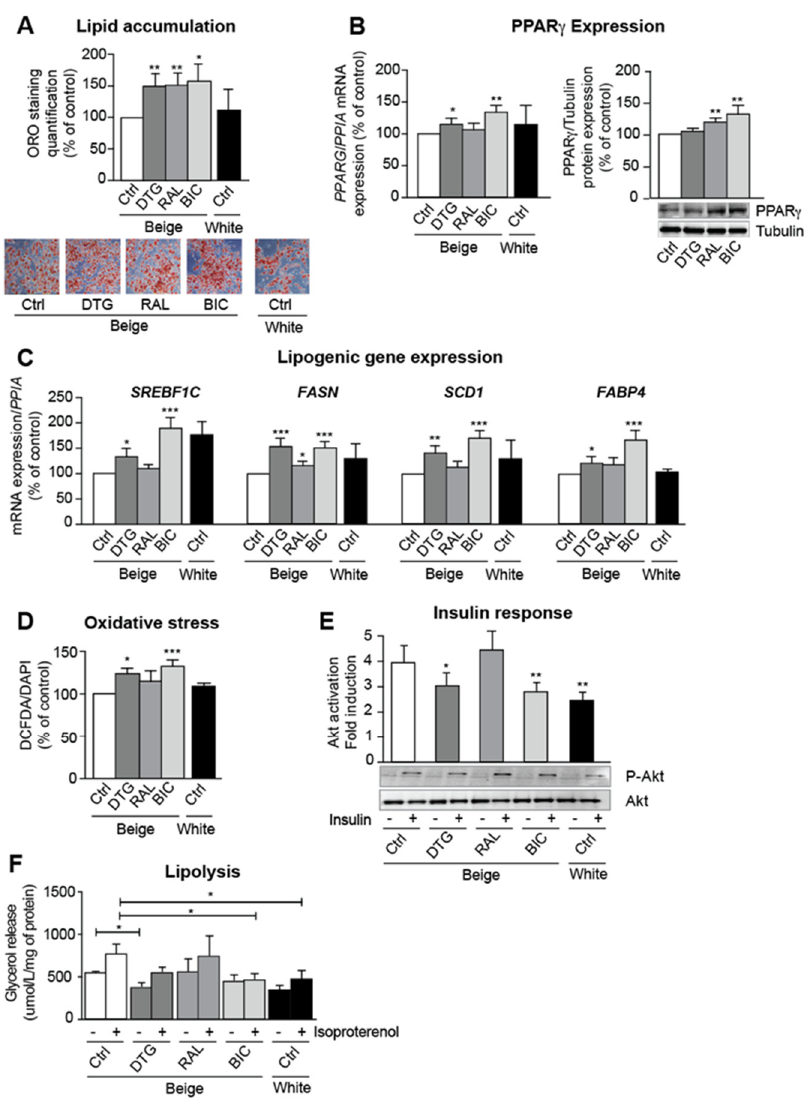
Figure 2. INSTI treatment is associated with greater lipid accumulation, pro-lipogenic marker expression, and insulin resistance in beige adipocytes in vitro. ASCs were differentiated into beige adipocytes in the presence of DMSO (Ctrl), dolutegravir/DTG, raltegravir/RAL, or bictegravir/BIC or differentiated into white adipocytes with DMSO (Ctrl) for 14 days. ( A ) Representative pictures are shown (Magnification X10). Oil-Red-O staining was expressed as the mean ± SEM % of control cells ( n = 9, in triplicate). ( B ) The relative mRNA expression levels of PPARG were normalized against that of PPIA . The results are expressed as the mean ± SEM % of control cells (left panel) ( n = 9, in duplicate). Whole-cell lysates were prepared and analyzed using immunoblots. Representative immunoblots of PPAR γ and tubulin (loading control) are shown. Densitometry analyses ( n = 6) against tubulin as loading control were performed and expressed as a mean % of the value for con- trol cells ± SEM (right panel) ( n = 6). ( C ) The relative mRNA expression levels of sterol-regulatory- element-binding-factor-1c (SREBF1C), fatty acid synthase (FASN), stearoyl-CoA-desaturase-1 (SCD1), and fatty-acid-binding-protein-4 (FABP4) were normalized against that of PPIA . The results are expressed as the mean ± SEM % of control cells (left panel) ( n = 9, in duplicate). ( D ) ROS produc- tion was assessed by measuring the CM-H2DCFDA fluorescence (normalized against DAPI). The results are expressed as the mean ± SEM % of control cells ( n = 9, in triplicate). ( E ) The cells were stimulated (or not) with 100 nM insulin for 7 min. Whole-cell lysates were prepared and analyzed using immunoblots. Representative immunoblots of phospho-Akt, total Akt are shown. The fold induction by insulin was quantified. The results are expressed as the mean ± SEM ( n = 6). ( F ) Lipol- ysis was evaluated by measuring glycerol release in adipocytes stimulated (or not) with 1 µM iso- proterenol (normalized against protein content). The results are expressed as the mean ± SEM ( n = 3, in duplicate). * p < 0.05, ** p < 0.01, *** p < 0.001 vs. control cells.